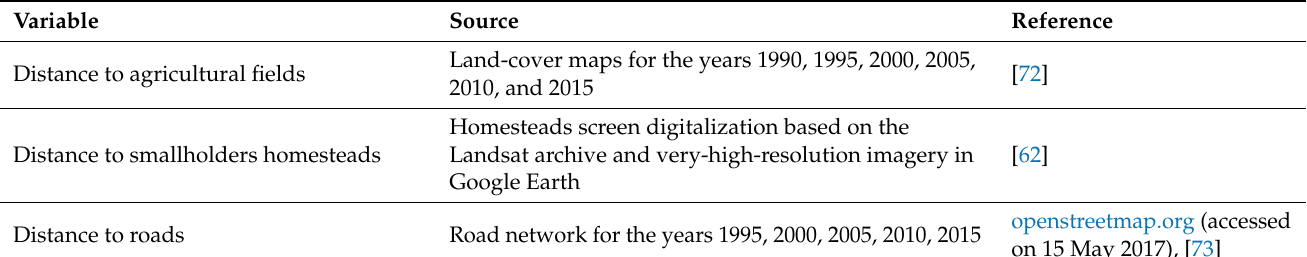
Table 2. Anthropogenic features in the Chaco landscape used for the analysis of the spatial distribu- tion of disturbance agents.